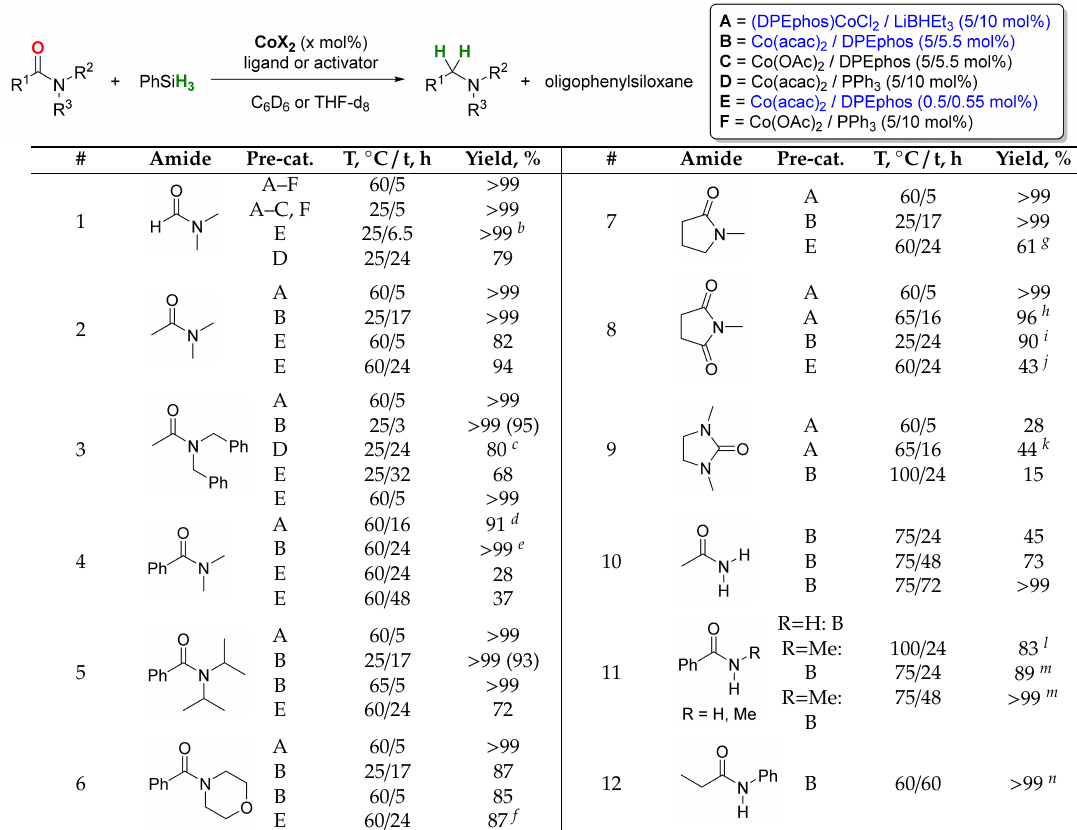
Table 1. CoX 2 / DPEphos-catalyzed (X = Cl, OAc, acac) deoxygenative hydrosilylation of amides a